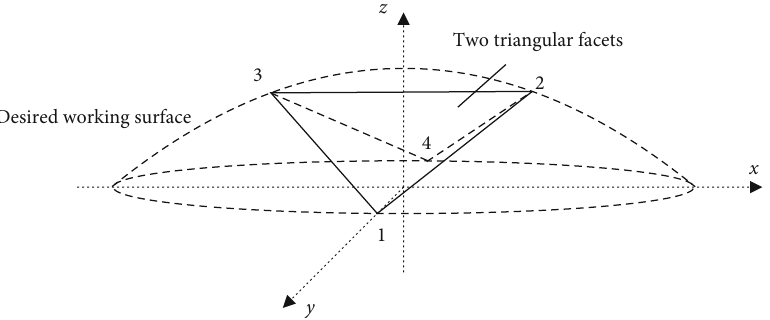
Figure 15: Two triangular facets with nodes being placed on the desired working